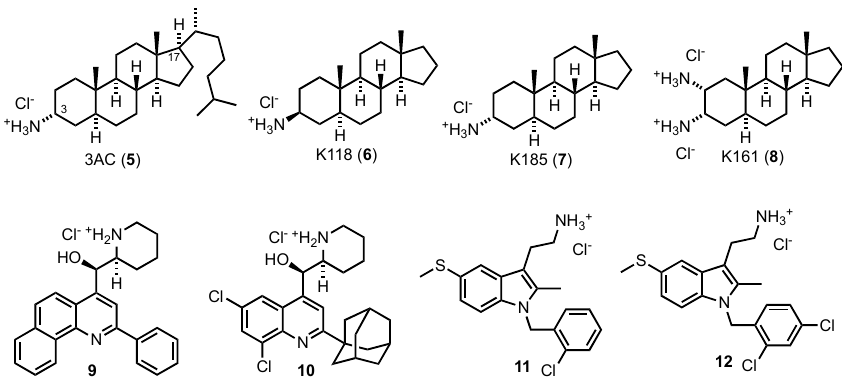
Figure 7. Aminosteroids, quinoline and tryptamine SHIP antagonists from Kerr and co-workers.